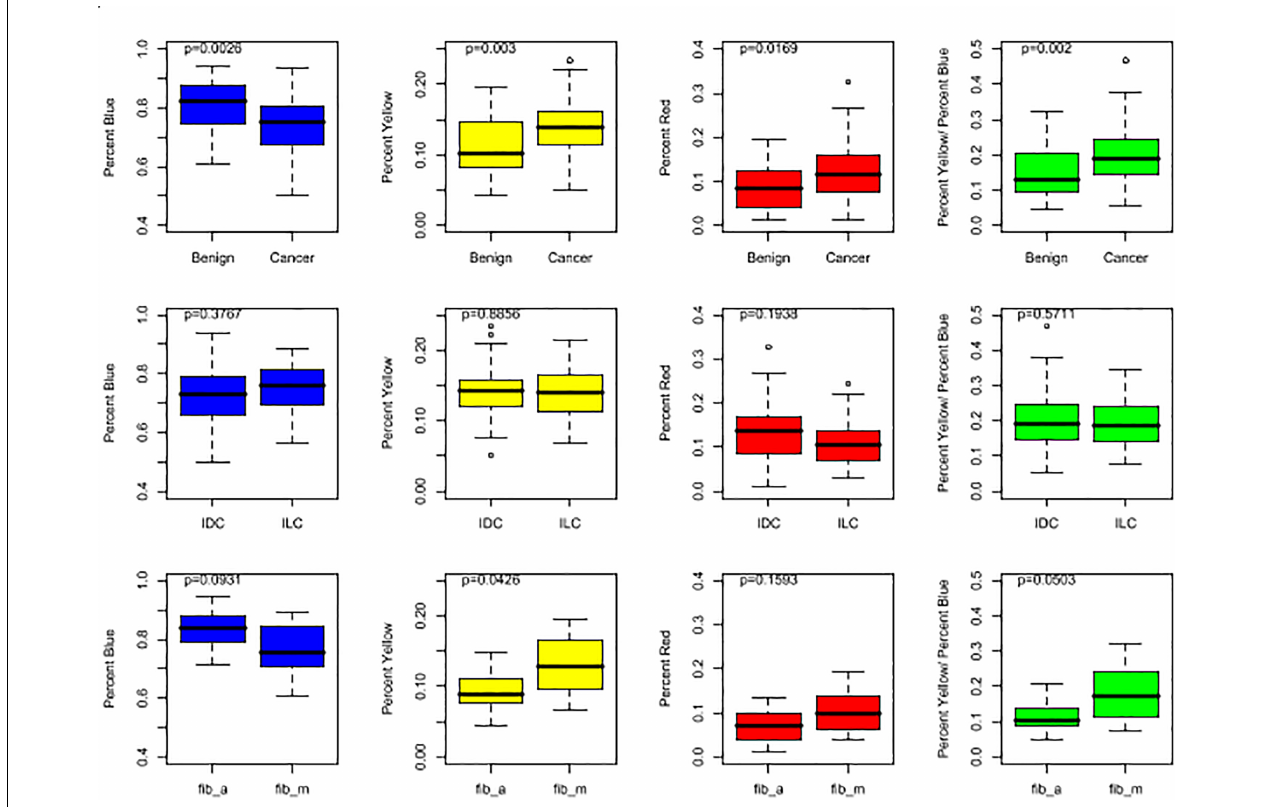
FIGURE 2 | Box plots representing the distributions of %B (in blue), %Y (in yellow), %R (in red), and %Y/%B (in green). For the top row, all cases are included for both cancer and benign patients. In the middle row, the IDC population is compared to the ILC population. In the bottom row, the two benign subgroups, fib_a and fib_m, are compared. The p -values shown at the top of each plot were obtained by running a non-parametric Wilcoxon Rank Sum test.